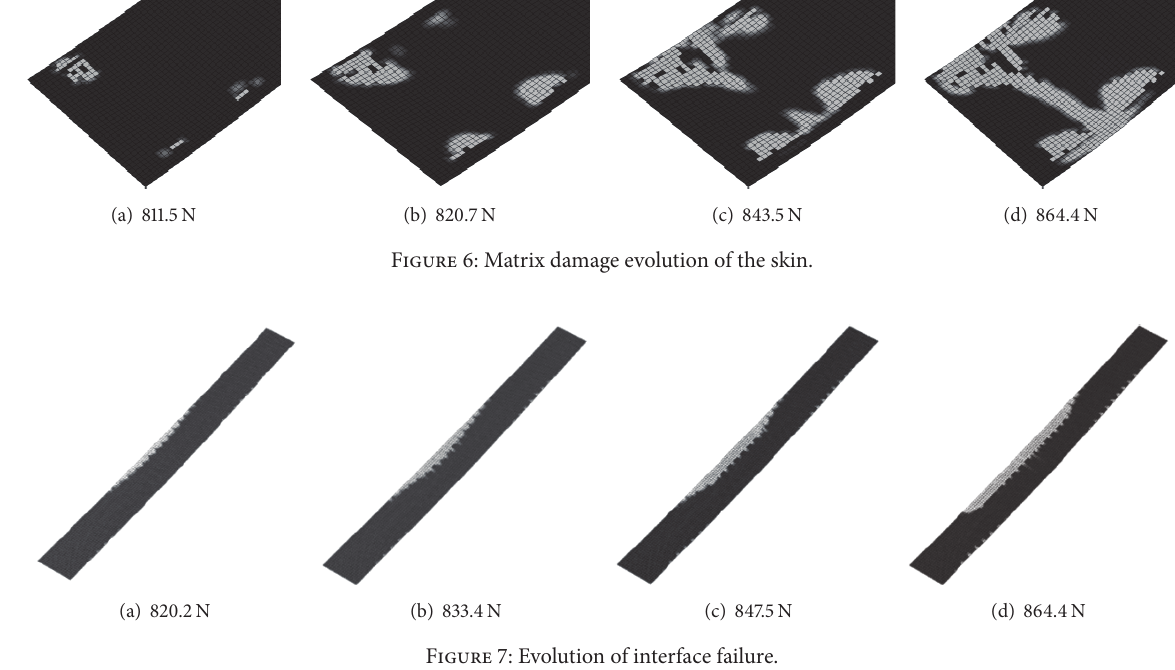
Figure 7: Evolution of interface failure.